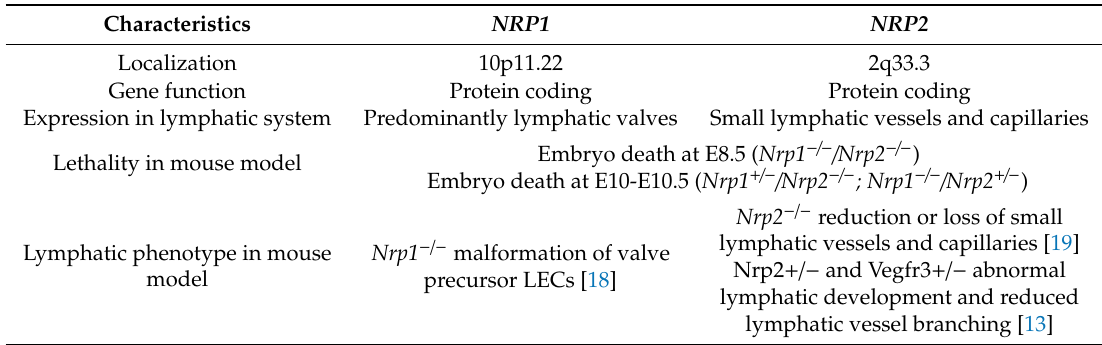
Table 1. Comparison of NRP1 and